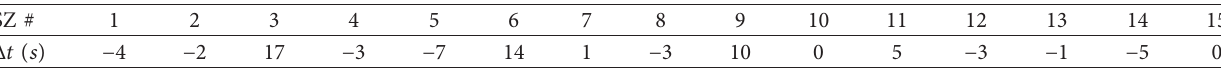
Table 5: Difference Δ t ( s ) between the alarm time given by CNN and the seizure onset time provided by the neurologists for the three patients.